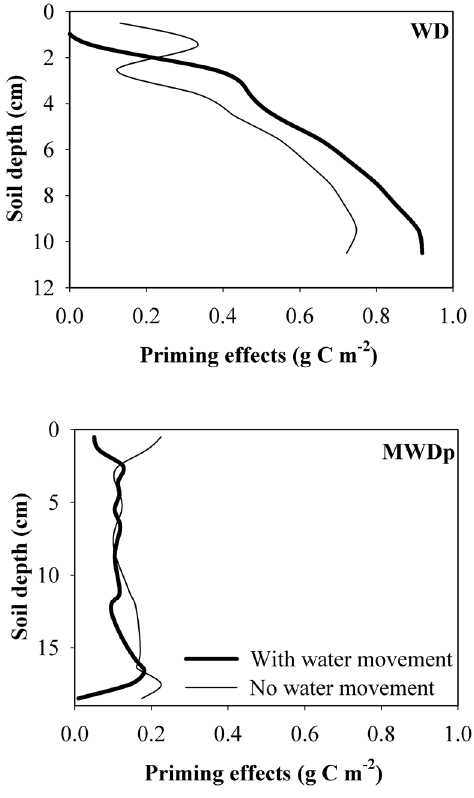
Figure 6. Simulated priming effects throughout the soil profile at each site (WD and MWDp) with total DOC input equal to 30% of NPP, DOC input occurring every 60 hours, and the fraction of microbial necromass apportioned to SOC equal to 0.5. The curves ‘‘with water movement’’ were derived based on the equation (1) while the curves ‘‘no water movement’’ were derived by setting the pore water velocity and diffusion coefficient equal to zero in equation